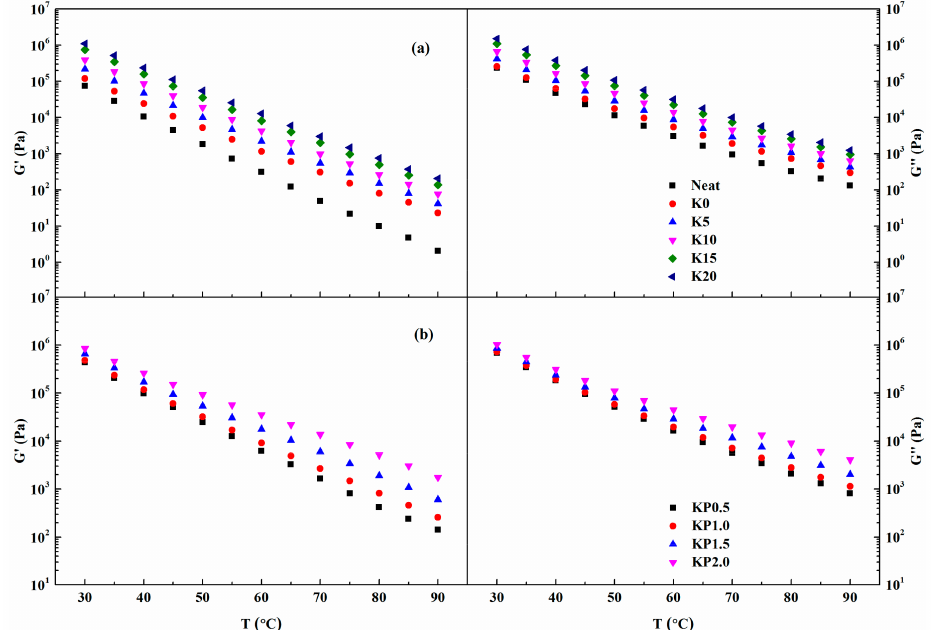
Figure 3. Variations in G (cid:48) and G” with temperature: ( a ) SBS/OSDOA-modified asphalts; ( b ) compos- ite modified